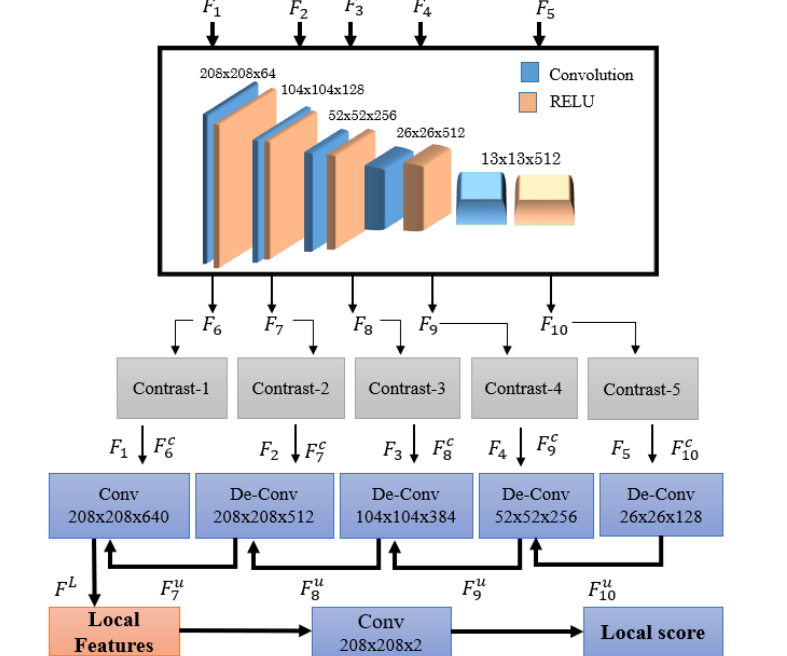
Figure 2. Extraction of local features. Local feature map produced by integration of contrast features, feature maps produced from convolutional layers, and upsampled feature maps.